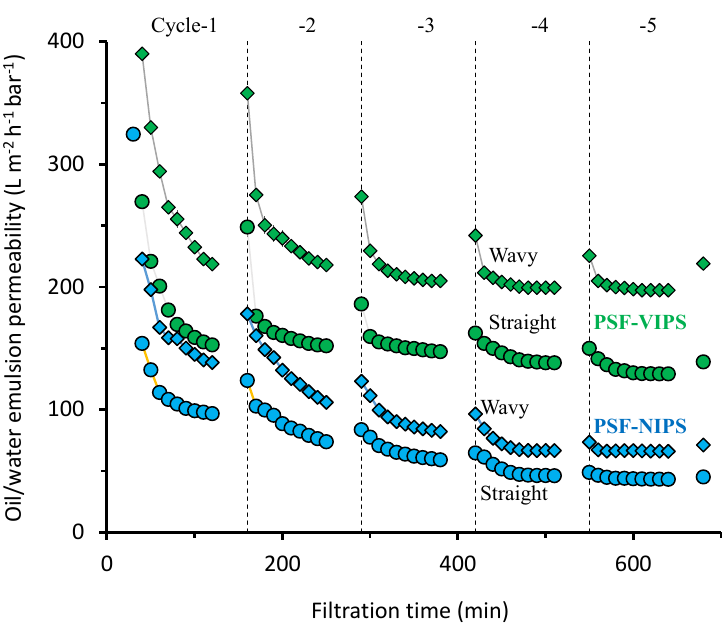
Figure 3. Effect of flow channel modification on membrane performance during oil/water emulsion filtration by also counting the advantage of additional surface area in the wavy flow channel.